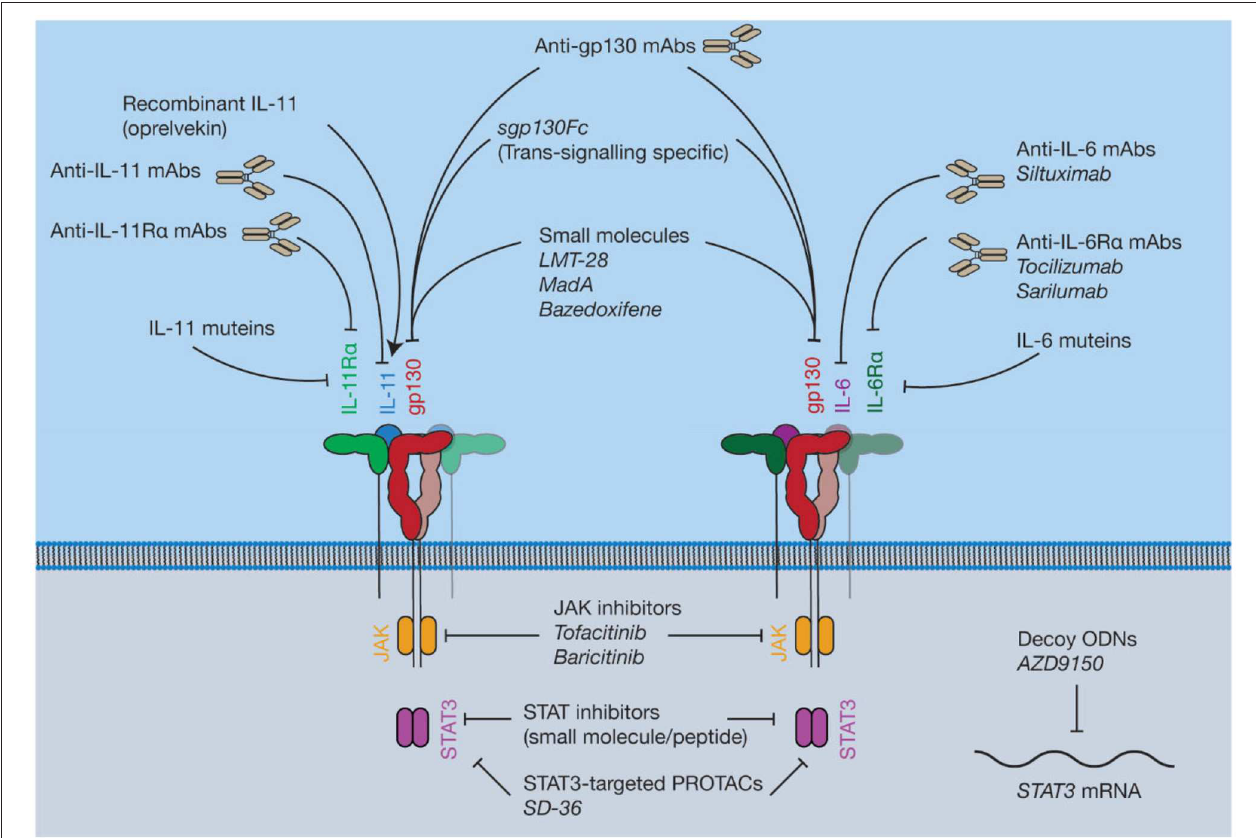
FIGURE 7 | Pharmacological approaches to target IL-6 and IL-11 signaling. Current inhibitors of IL-6 and IL-11 signaling include protein antagonists such as cytokine mutants and antibodies, small molecule protein-protein interaction (PPI) inhibitors targeting gp130, recombinant IL-11, small molecule inhibitors of proteins in the intracellular JAK-STAT pathway, and decoy oligodeoxynucleotides (ODNs) targeting the STAT3